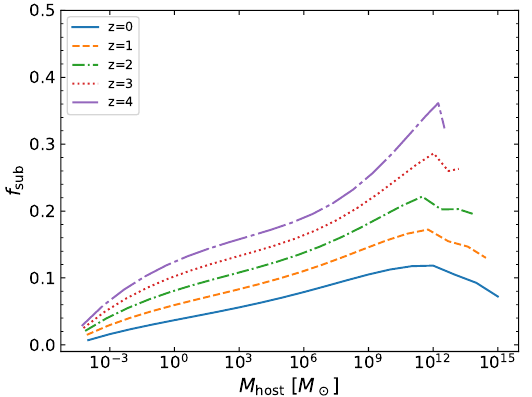
10 − 4 to 10 14 M and redshifts (cid:39) (cid:12)